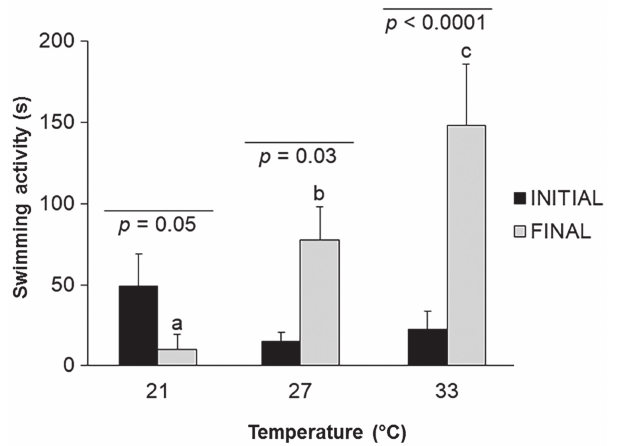
Fig. 1. Mean ± SE of initial (third day) and final (eighth day) latency of swimming activity of isolated fish Cichlasoma paranaense . Different letters indicate statistical significance among treatments. Mixed Model ANOVA completed by Fisher-LSD post hoc